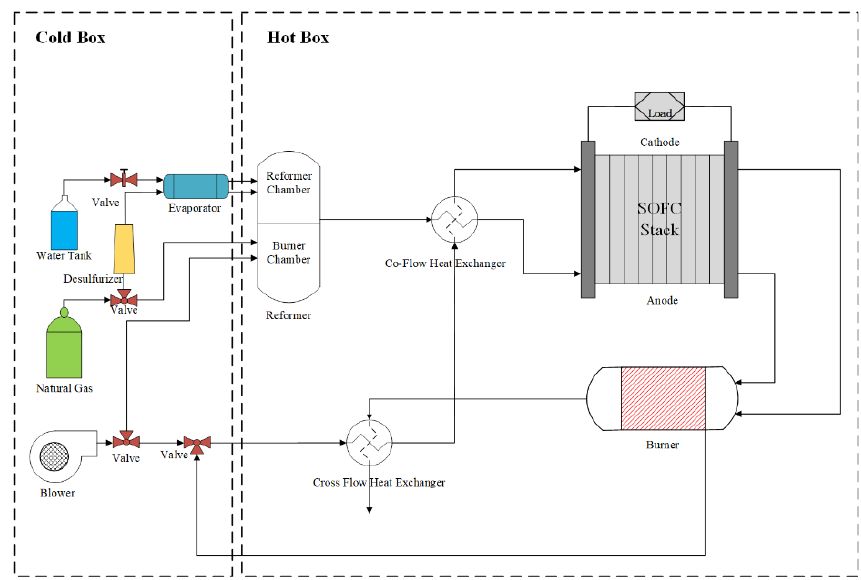
Figure 2. SOFC system